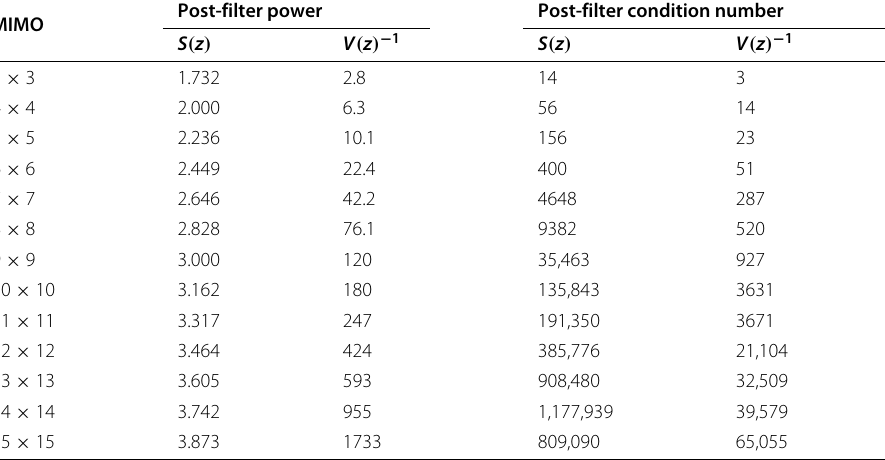
Table 1 Left-right swapping vs row balancing: comparison of powers and condition numbers Post-filter power Post-filter condition number MIMO S ( z ) V ( z ) −